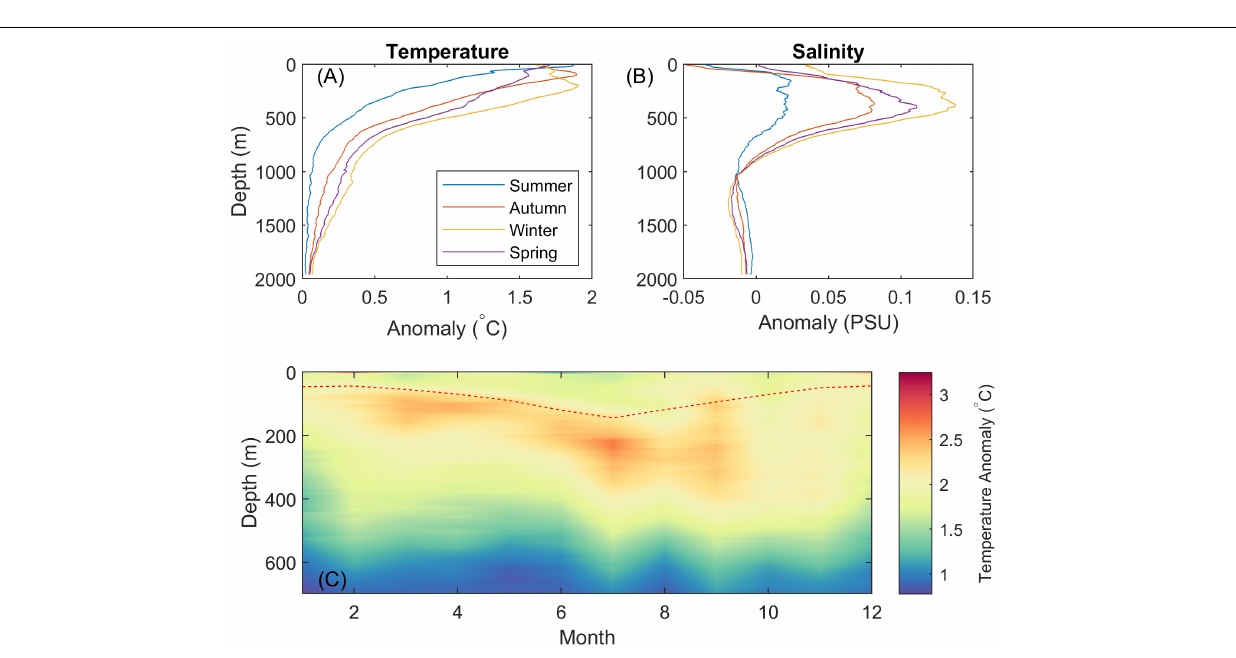
FIGURE 9 | Mean seasonal depth profiles of temperature (A) and salinity (B) anomalies during MHWs. (C) Monthly composites of temperature anomaly during MHWs. The monthly mean MLD (red dashed line) is